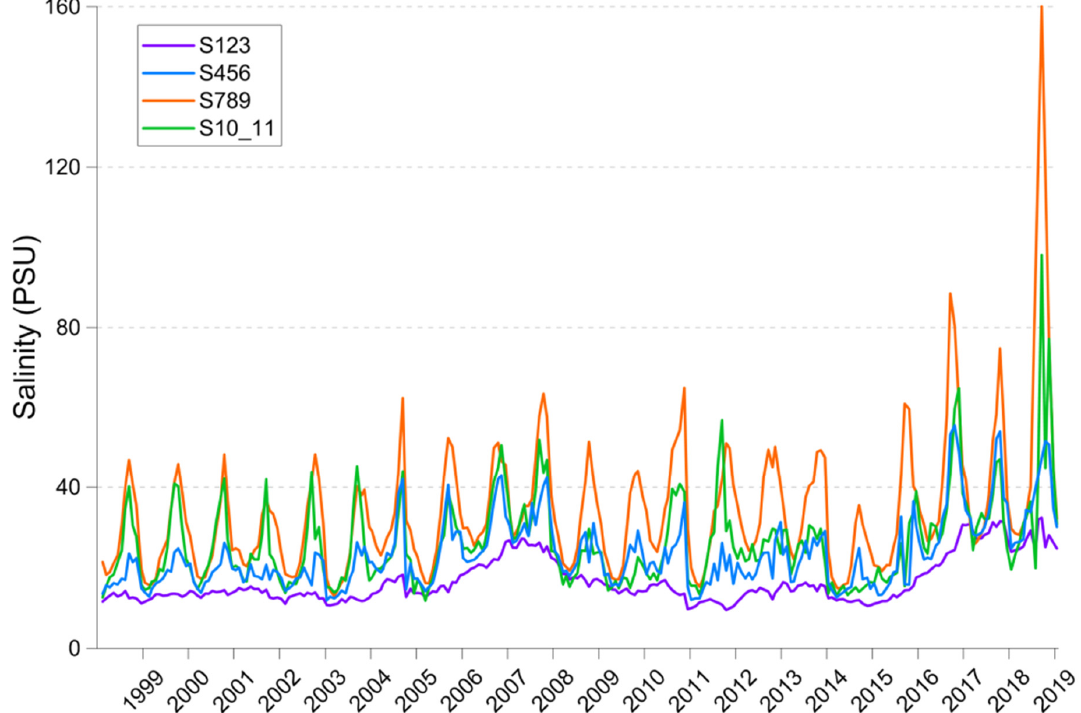
Figure 9. Monthly variations in the average salinity from 1999 to 2019, for (i) the Vaccar è s lagoon (“S123”: average value of the salinities measured at the locations 1, 2, and 3 (Figure 2)); (ii) the Imp é riaux lagoons (“S789”: average value of the